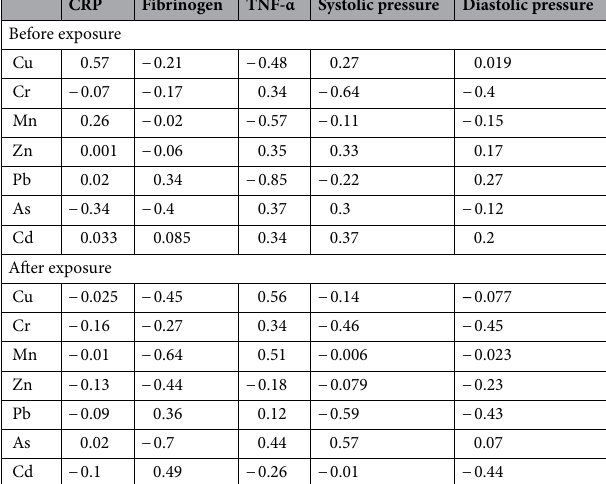
Table 4. The correlation between cardiovascular biomarkers and the concentration of heavy metals on PM 10